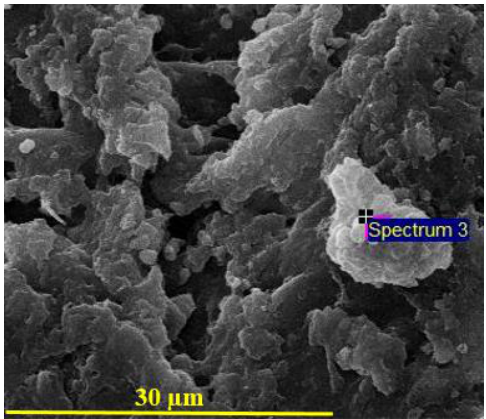
Figure 2. Scanning electron microscopic image of collagenic material (after chromium